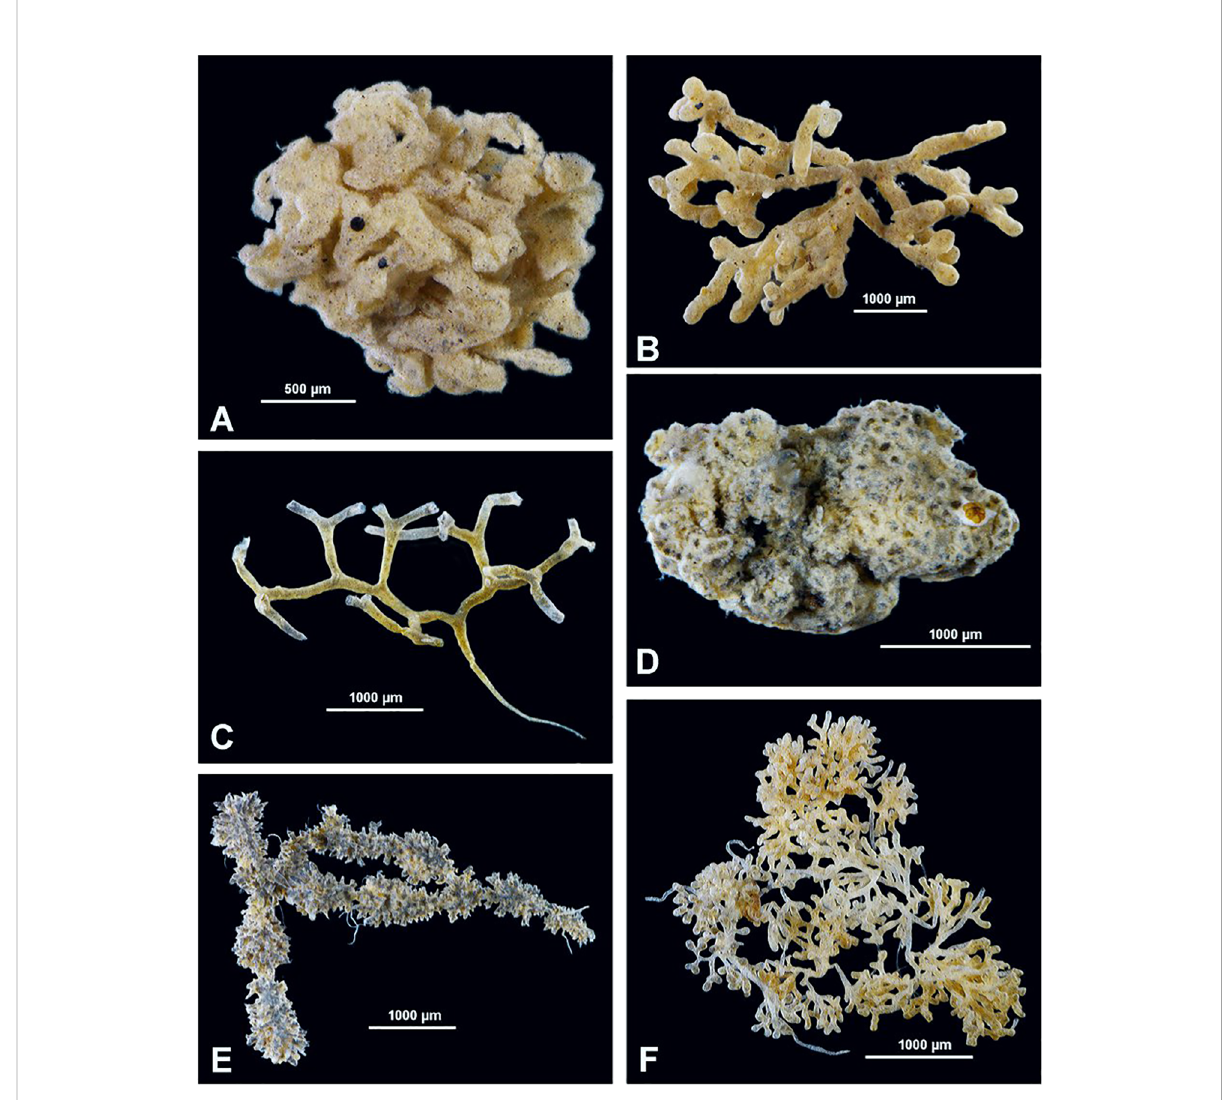
FIGURE 3 Various monothalamids. (A) Cerebrum -like form; French area, sample 158. (B) Cluster of wide tubes; Belgium area, sample 133. (C) Dichotomously branching tree A; APEI-3, sample 192. (D) Mudball with big chambers; German area, sample 50. (E) Chain with prominent tubercles; APEI-3, sample 192. (F) ? Edgertonia sp. 5; French area, sample